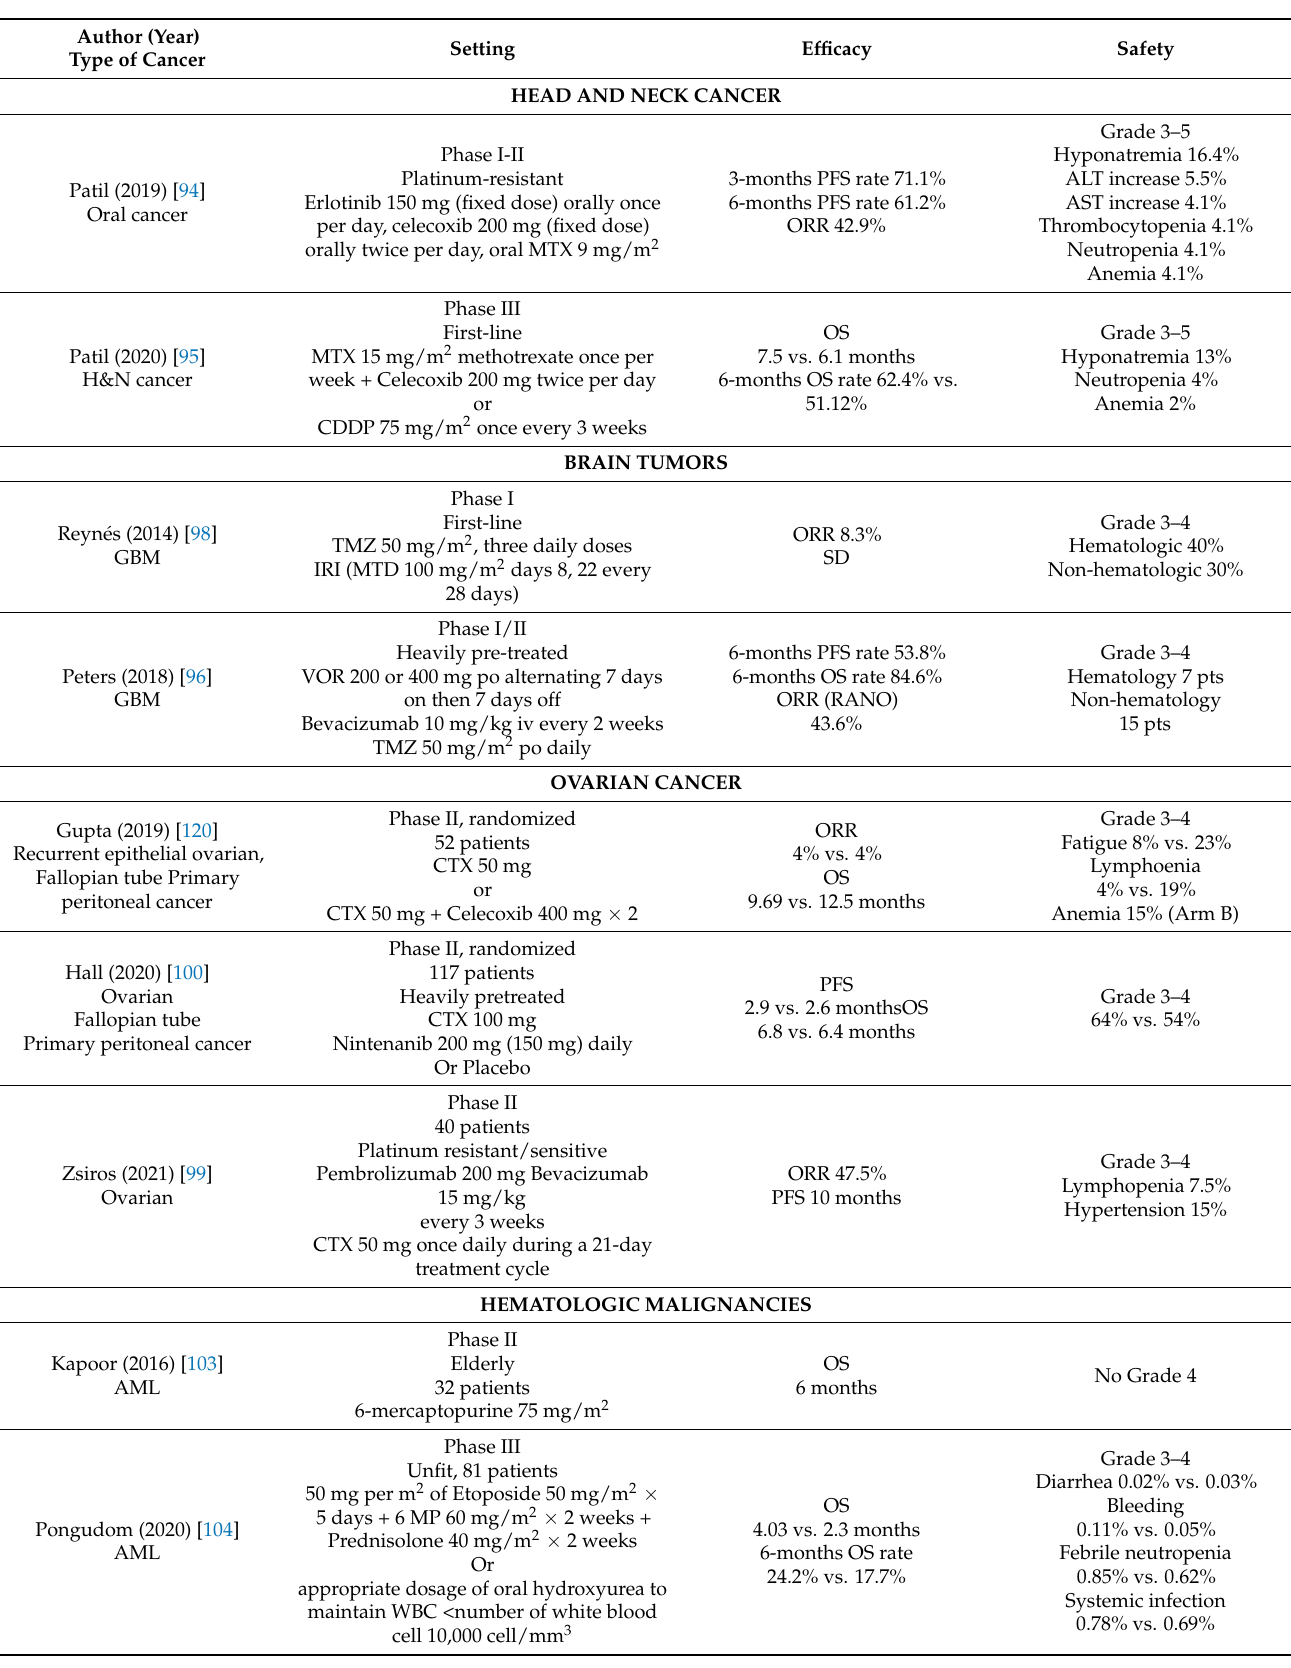
Table 3. Summary of results of trials using mCHT in different cancers (H&N, GBL, ovarian cancer,